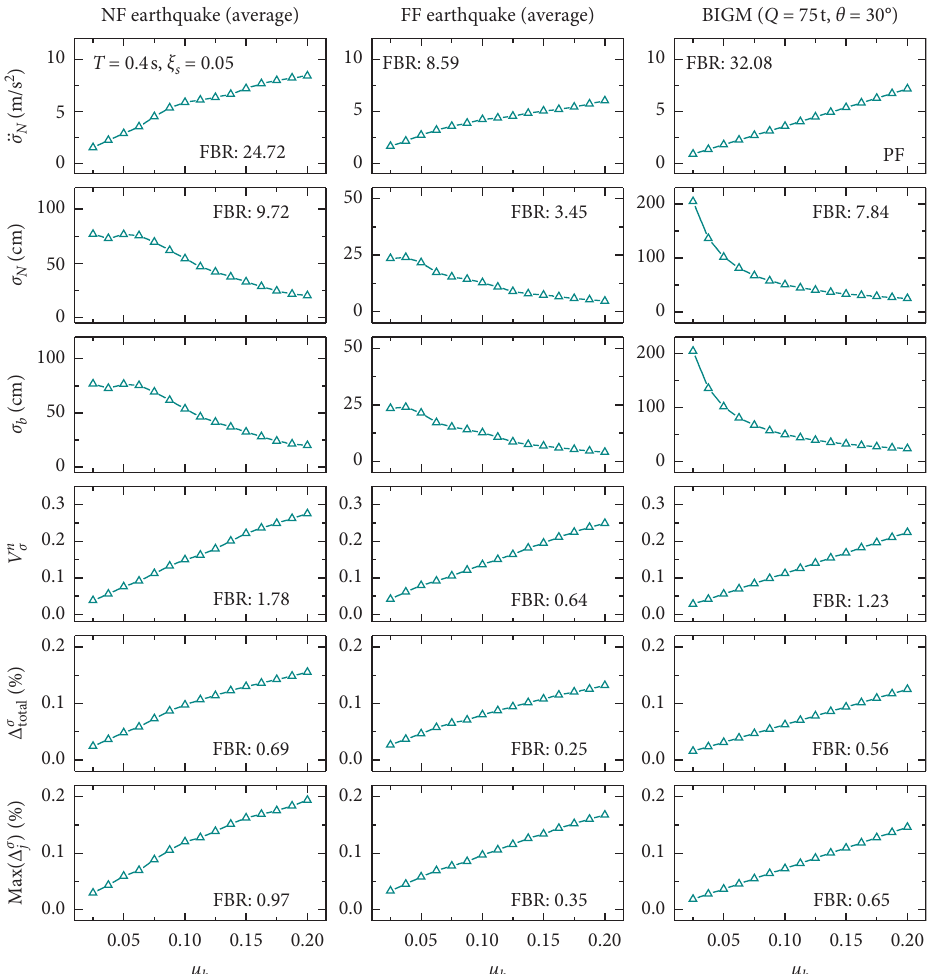
Figure 11: The response of a four-story building T � 0.4 s; ξ